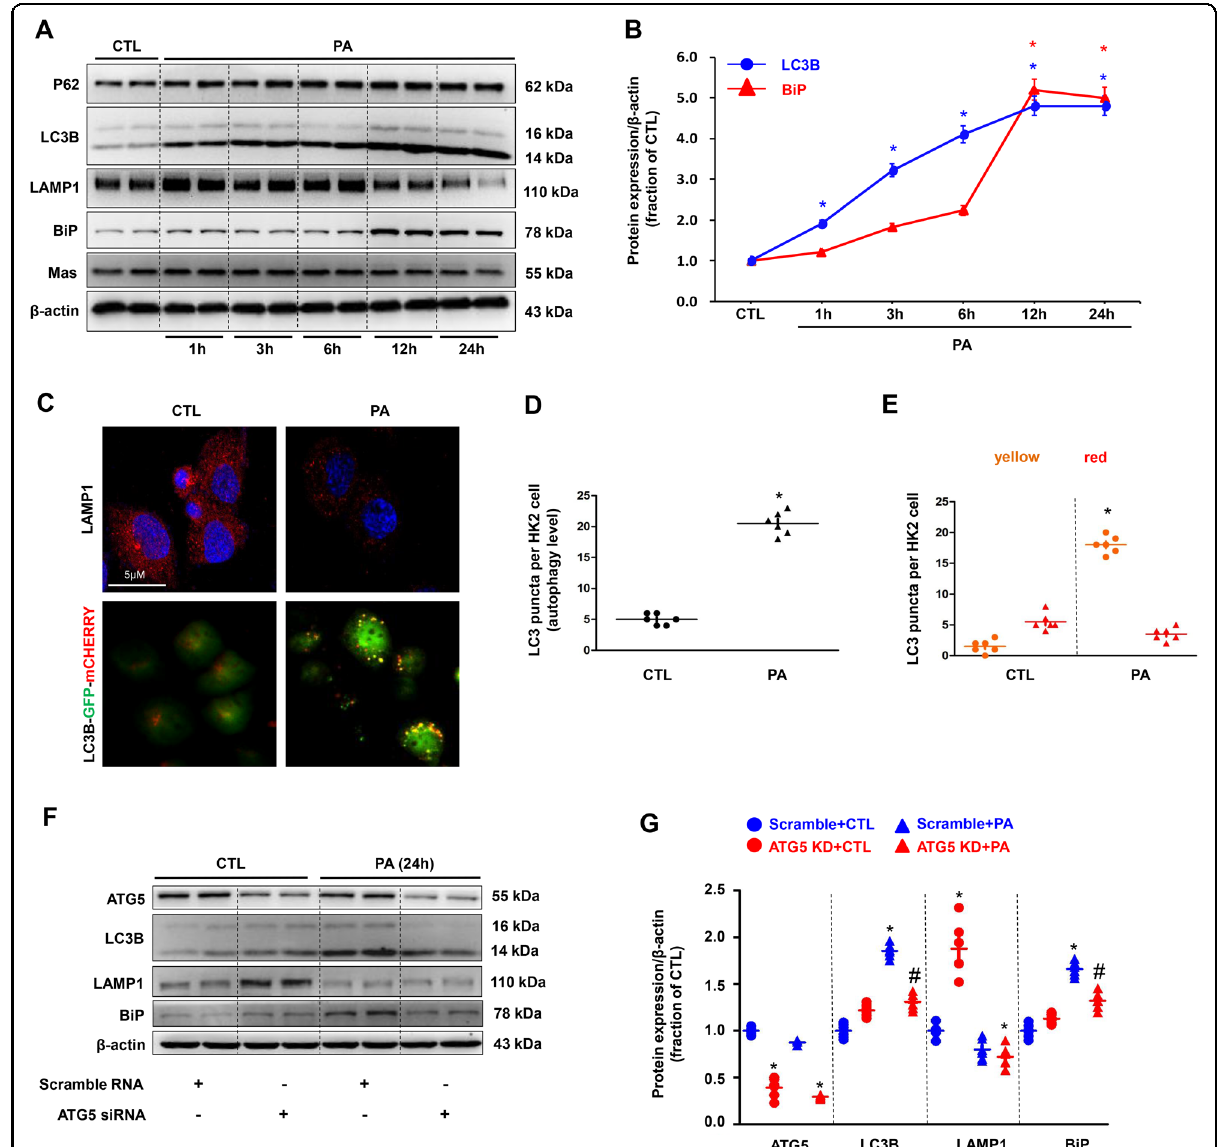
Fig. 3 Palmitic acid (PA) induced impaired autophagy and ER stress in HK2 cells. A Representative immunoblots of autophagy protein markers (assessed by P62, LC3B and LAMP1) and activation of the ER stress (assessed by BiP) in cultured HK2 cells treated with PA (400 μ M) for 1 h, 3 h, 6 h, 12 h, 24 h. β -actin was used as a loading control. B Dynamic changes of LC3B and BiP protein expression in HK2 cells treated with PA. C Confocal microscopy images of LAMP1 (red) and autophagic fl ux estimated by the formation of LC3B puncta in HK2 cells treated with or without PA. D The number of GFP-positive puncta was counted in HK2 cells. E Autophagy fl ux was detected by the ratio of yellow puncta (GFP and mCherry double- positive) in all LC3B puncta. High ratio of double-positive puncta in PA treatment group indicated PA induced impaired autophagy in HK2 cells. F and G Representative immunoblots and corresponding densitometry analysis of autophagy and ER stress protein markers in HK2 cells with ATG5 siRNA after PA treatment. Data are shown as mean ± SEM; * P < 0.05 compared with CTL; # P < 0.05 compared with PA. The experiment was repeated three